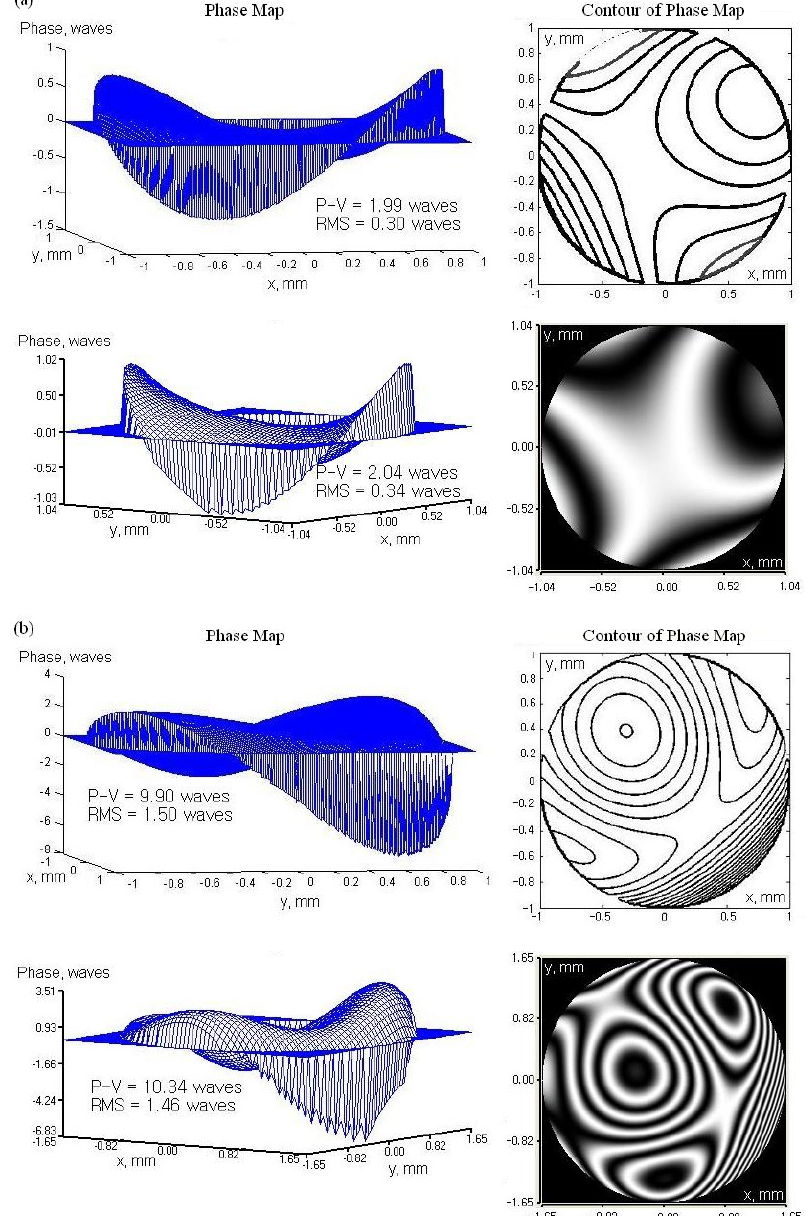
Figure 10. Wavefront measurement results of (a) PAL and (b) PCX by our SHWS (above) and commercial SHWS